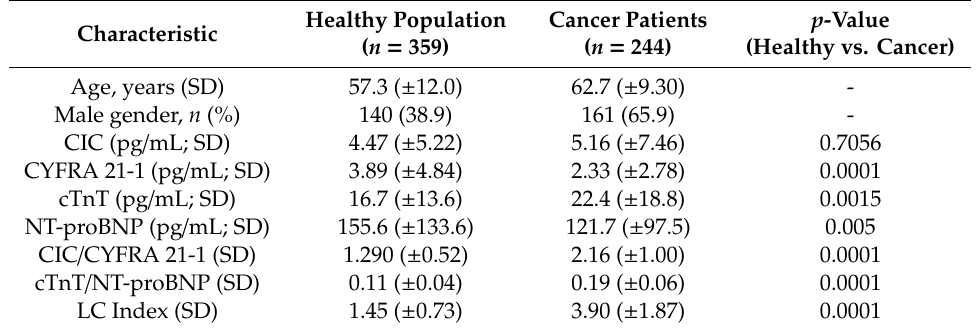
Table 3. Characteristics of the Study Participants ( n =